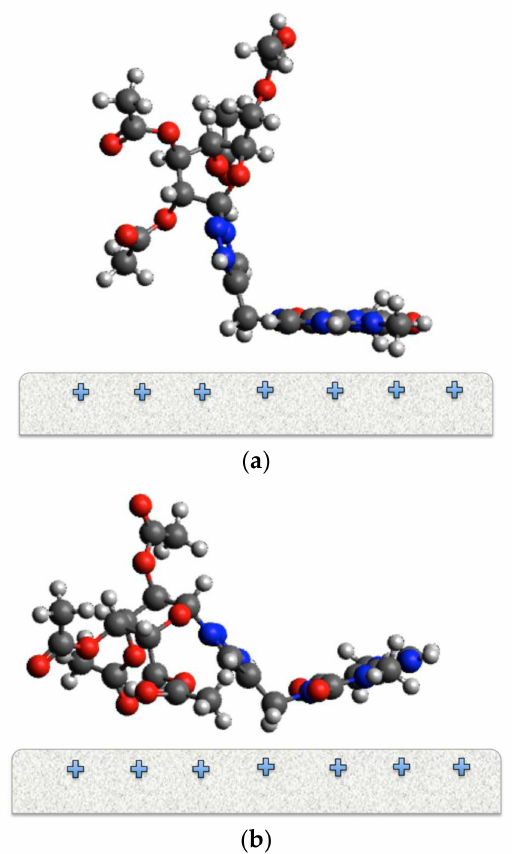
Figure 16. Presumable molecular adsorptions for, ( a ) Molecule 3a and ( b ) Molecule 3d